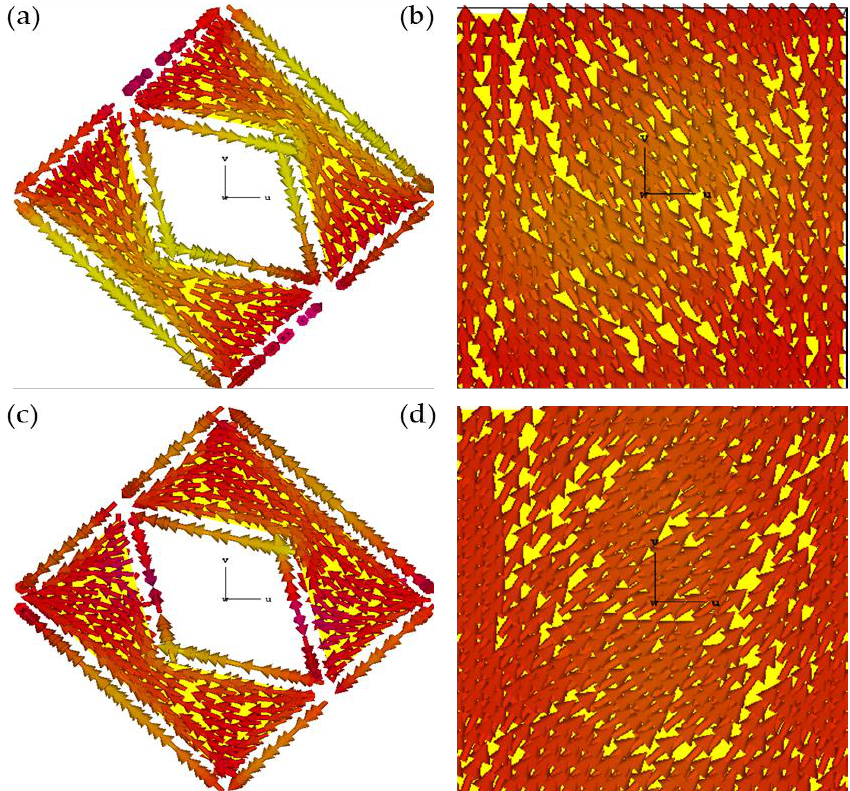
Figure 5. Surface current distribution of the proposed anisotropic reflective metasurface at the top and bottom metallic layers at various resonant frequencies. ( a , b ) 13.8 GHz, ( c , d ) 19.7 GHz.